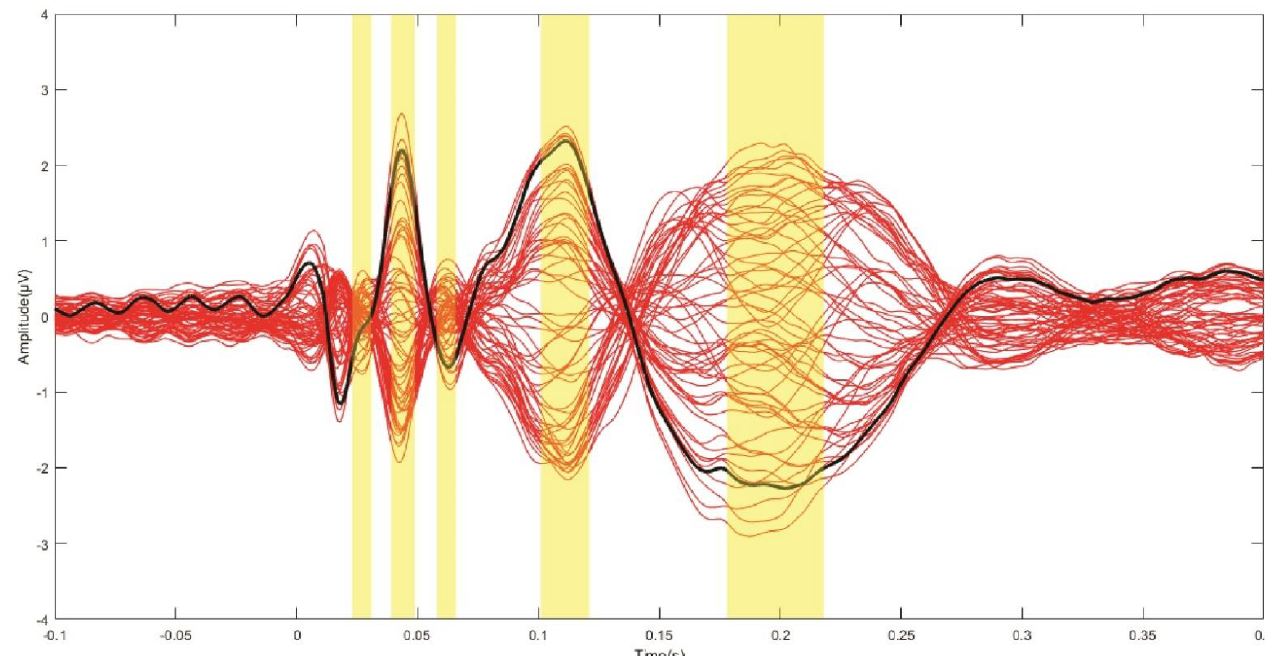
Figure 2. Grande average TEP across subjects and conditions. Each red line depicts the TEP from one electrode. The thick black line indicates the TEP averaged across the four electrodes from which the LMFP was calculated (Fz, F2, FCz, FC2). The yellow panels indicate the time windows from which maximum/minimum values of TEP peak amplitudes were extracted (see text for details).